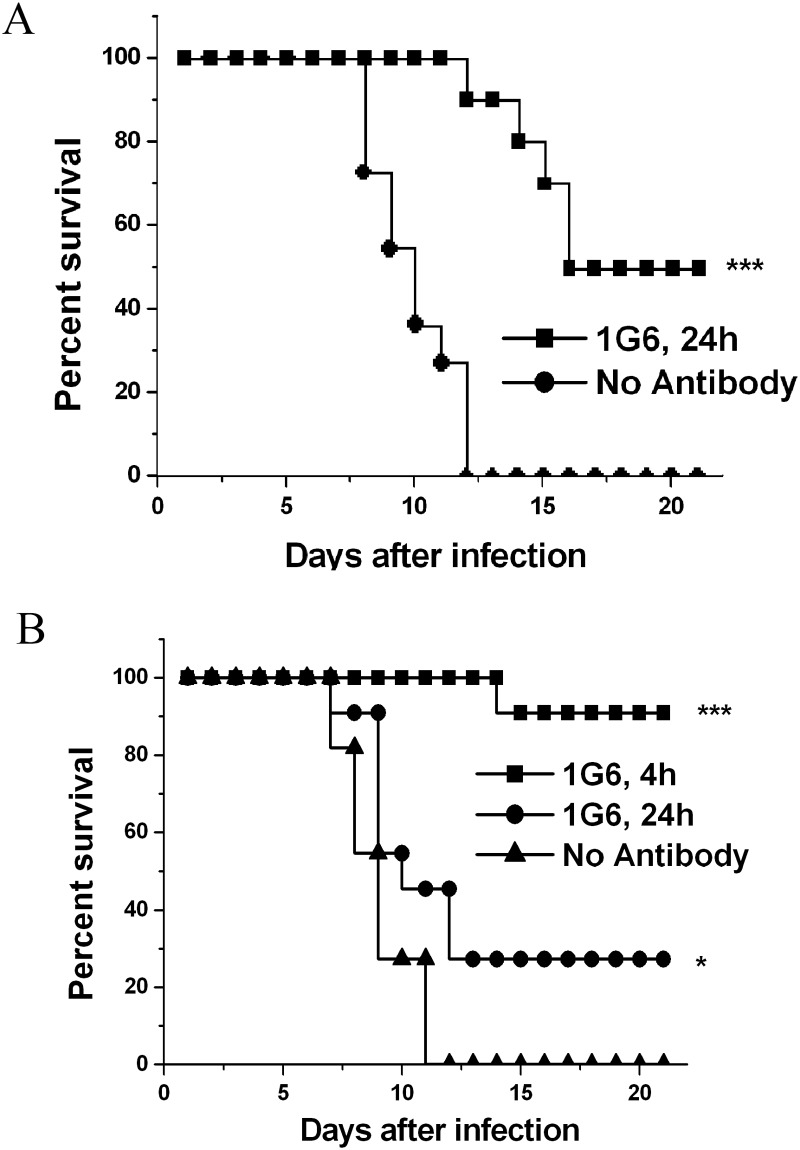
Prophylactic and therapeutic efficacy of 1G6 in suckling mice.
(A) Mice were administered saline or a single 50 μg dose of 1G6 via an IP route one day prior to infection and then infected intracerebrally with 105 PFU/ml of the mouse-adapted DENV–4 virus and monitored for survival for 21 days after infection. (B) Therapeutic efficacy of 1G6 was tested by administering a single 50 μg dose of 1G6 intraperitoneally 4h or 24h after infection with 105 PFU/ml intracerebrally. The number of suckling mice for each group ranged from 10 to 11. Kaplan—Meier survival curves were analyzed by the log-rank test and significant differences are indicated by asterisks (*** p<0.001; * p<0.05).